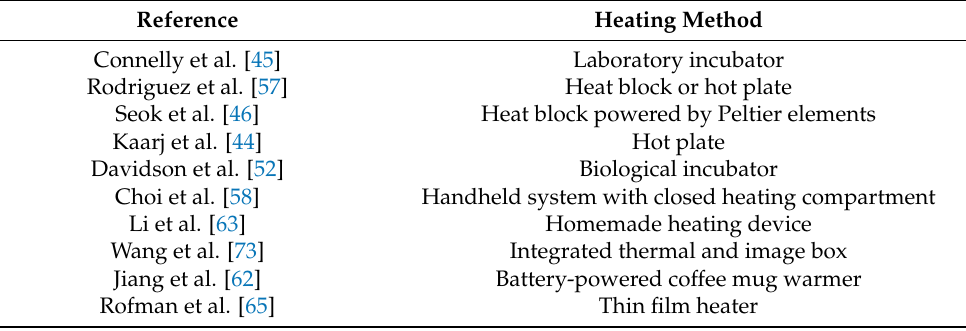
Table 2. Heating methods for paper-based LAMP